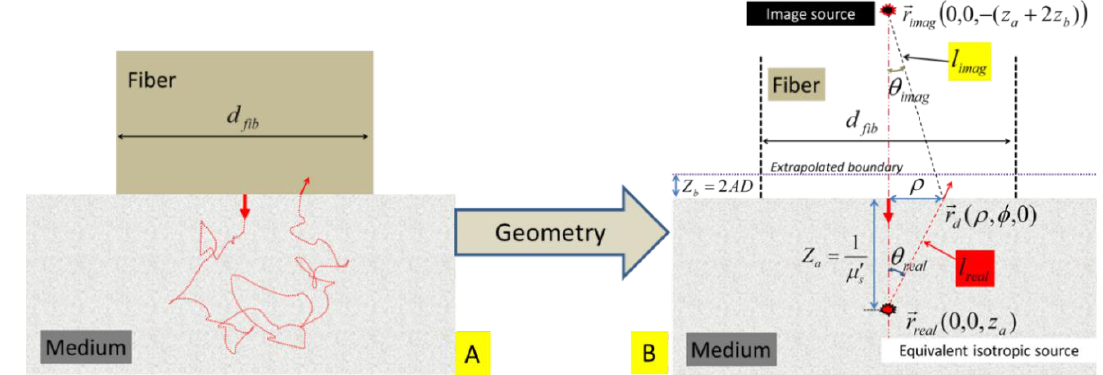
d fib  and a r real l with respect real z away from the b